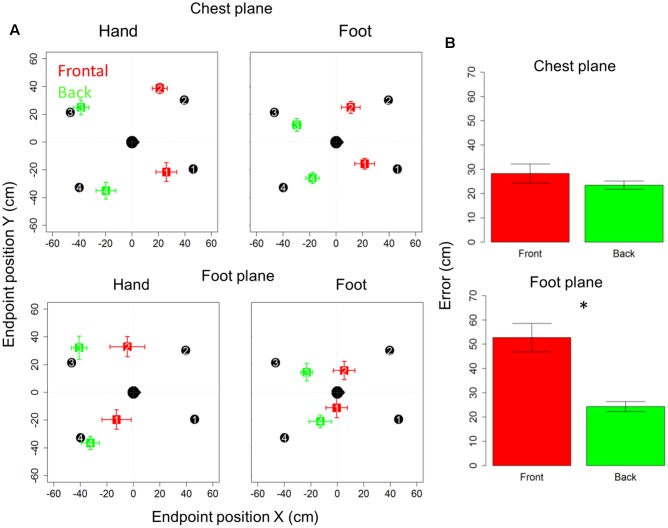
Bias and localization error in motor pointing task: (A) upper and lower rows represent sound levels: high and low, respectively; left and right columns represent the effector used: hand and foot, respectively. In each quadrant, the subject is indicated by the head at the center facing toward positive x-values. Black circles represent the four positions to be located, while colored squares denote the average of locations actually located: red and green squares, respectively, refer to the front and back longitudinal spaces, respectively. As can be seen, there is greater bias at foot level (red squares are shifted toward the back), while at chest level the bias disappears (green dots are almost superimposed on black dots). (B) Reports localization error (distance in cm between the end-point position signaled by the participant and position of the reference marker placed on the circumference). As can be seen, similar localization in front and back space is reported for sounds delivered at chest level, while greater localization error in the frontal space appears when sounds are delivered at foot level. Significant differences are illustrated (∗P < 0.05).